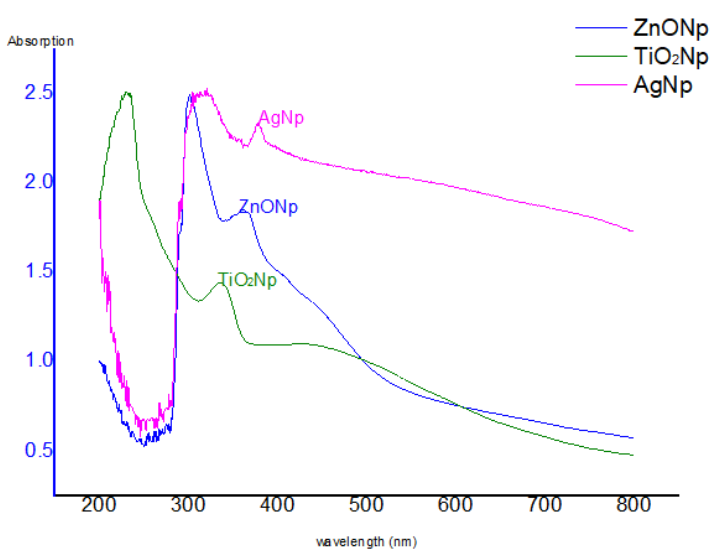
Figure 1. Ultra-violet visible spectrophotometer recorded after 72 h of reactions of solution of AgNPs, ZnONPsand TiO 2 NPs.